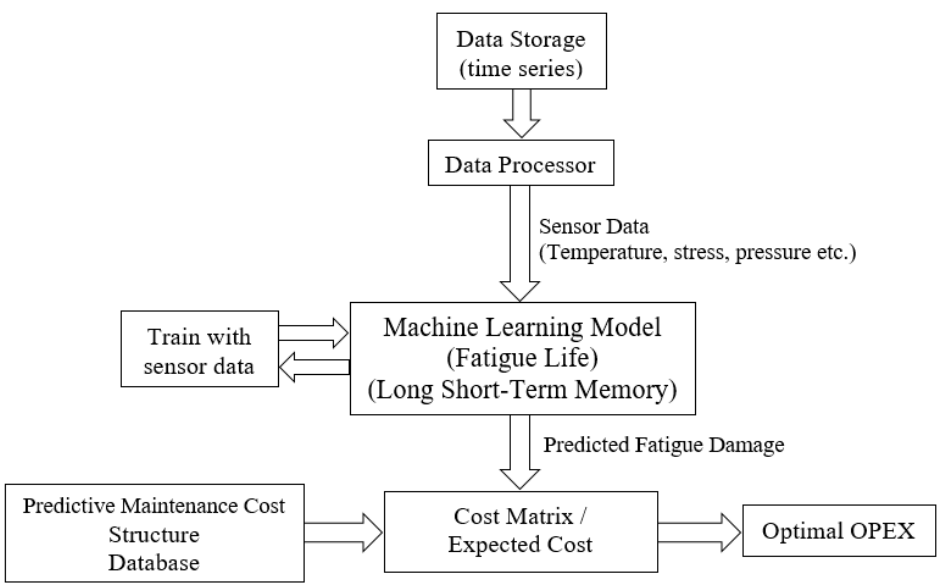
Figure 9. A predictive maintenance model based on sensor data analytics [4].